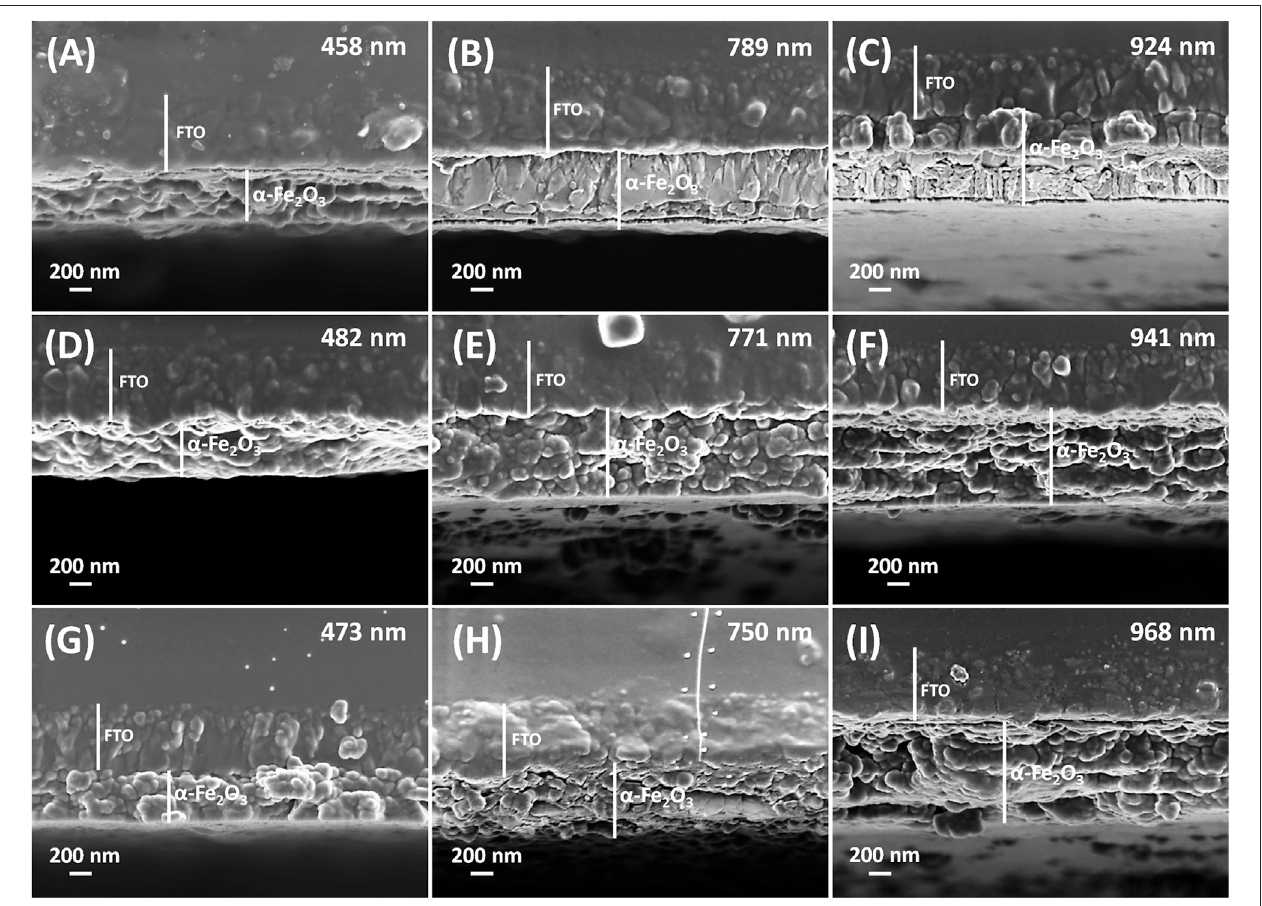
FIGURE 3 | FE-SEM cross-sectional views of samples (A) D30 (B) D60 and (C) D110 prepared using dip coating and (D) S4000 (E) S900 and (F) S600 for spin coated fi lms and (G) C30 (H) C60 and (I) C110 fabricated via the combined dip/spin coating techniques respectively.